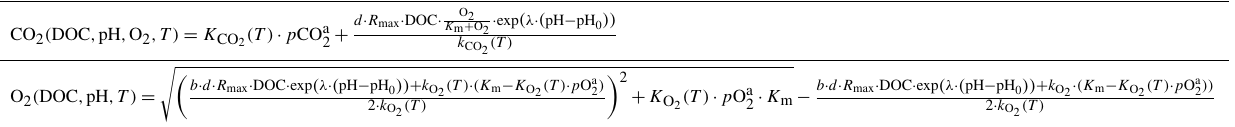
Table 2. Equations to derive CO 2 and O 2 based on the exponential pH